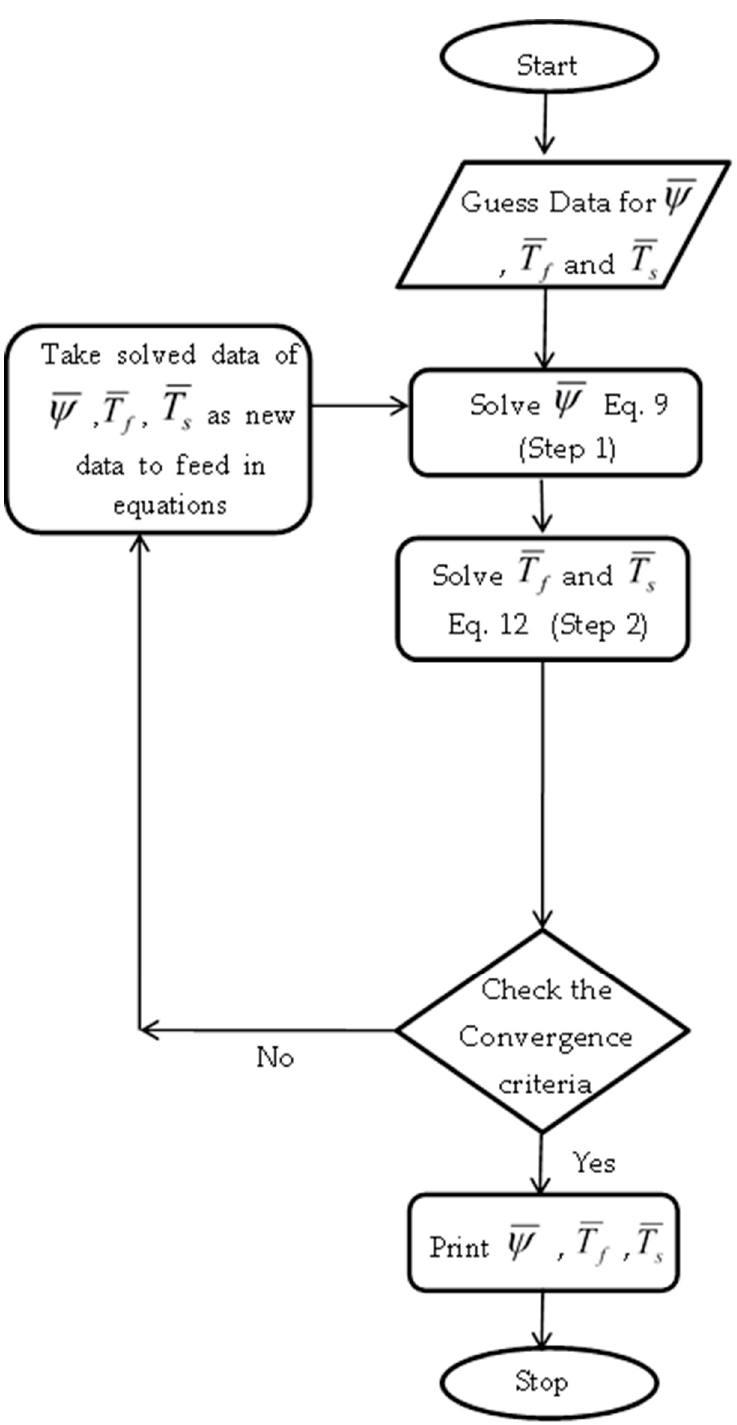
Figure 2. Flowchart of new method.